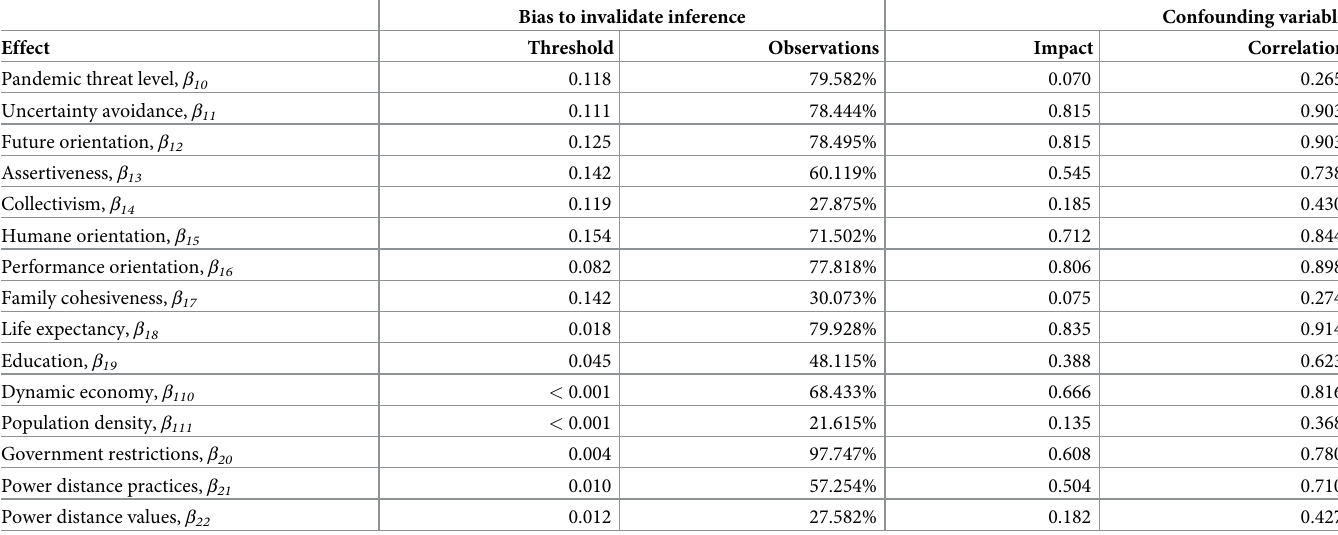
Table 4. Robustness of